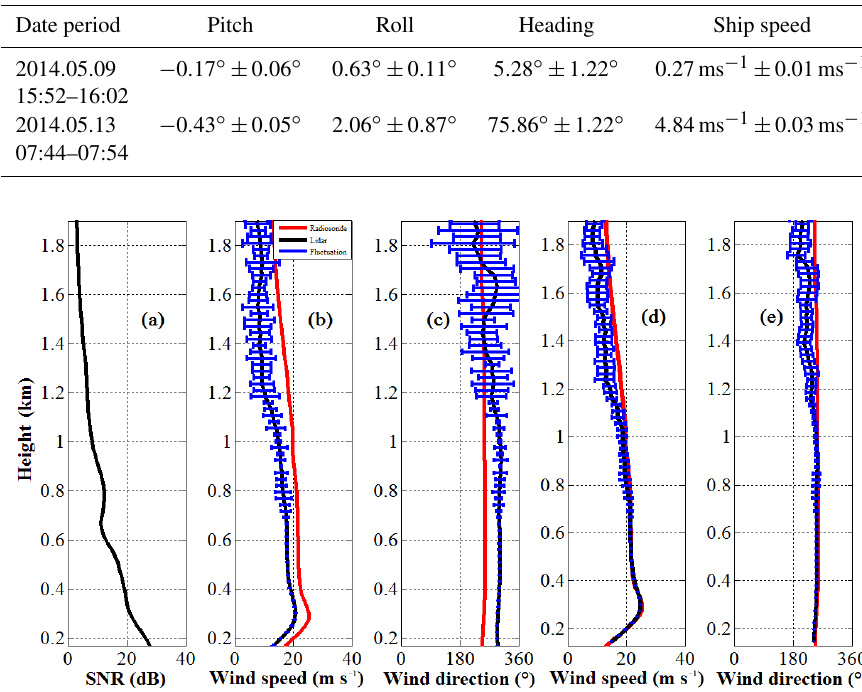
around 0.3 km where the wind speed exceeds 25 ms − 1 . Ad- 1 km is more severe than the result below 1 km. The spe- cific ship condition parameters are also listed in Table